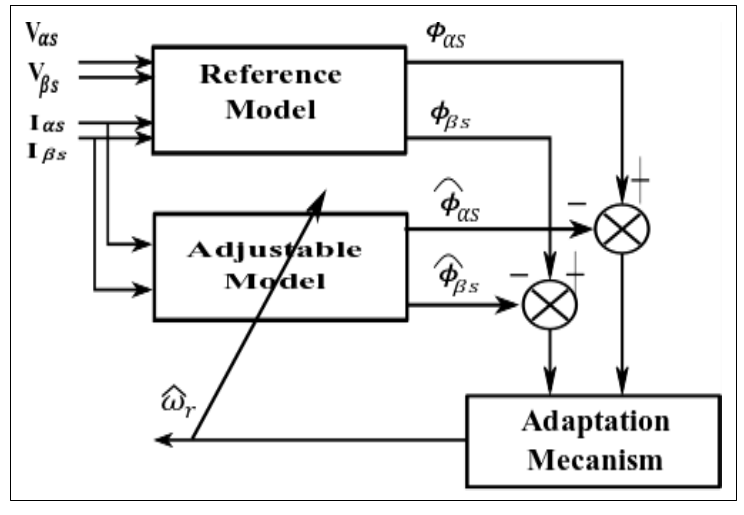
Figure 4. Classical MRAS